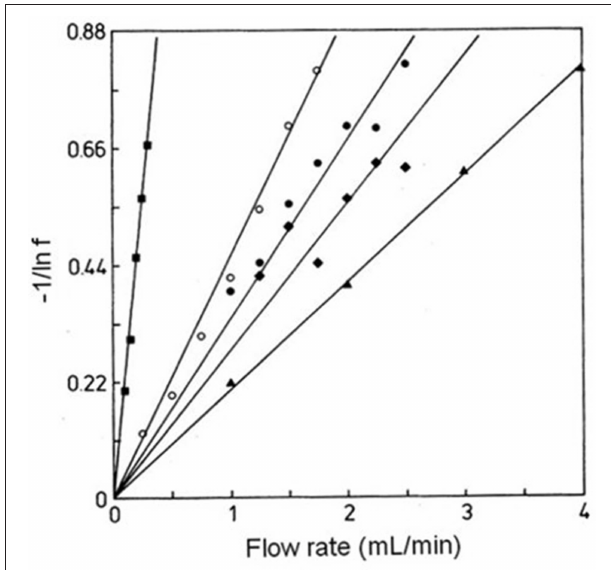
FIGURE 9 | Plots of 1/ln f vs. F for examining interactions of rabbit IgG with − immobilized protein A by the split-peak method. These experiments were conducted using various sample sizes, immobilization methods, and support materials, as represented by the plots in ( ), (•), ( N ), ( (cid:4) ), and ( (cid:7) ). Terms: f , free ◦ fraction of the analyte. Reproduced with permission from Hage et al. (1986). Copyright 1986 American Chemical